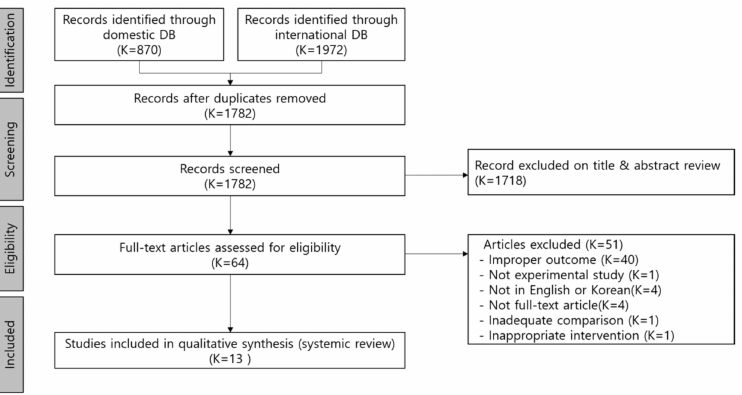
Figure 1. PRISMA flow